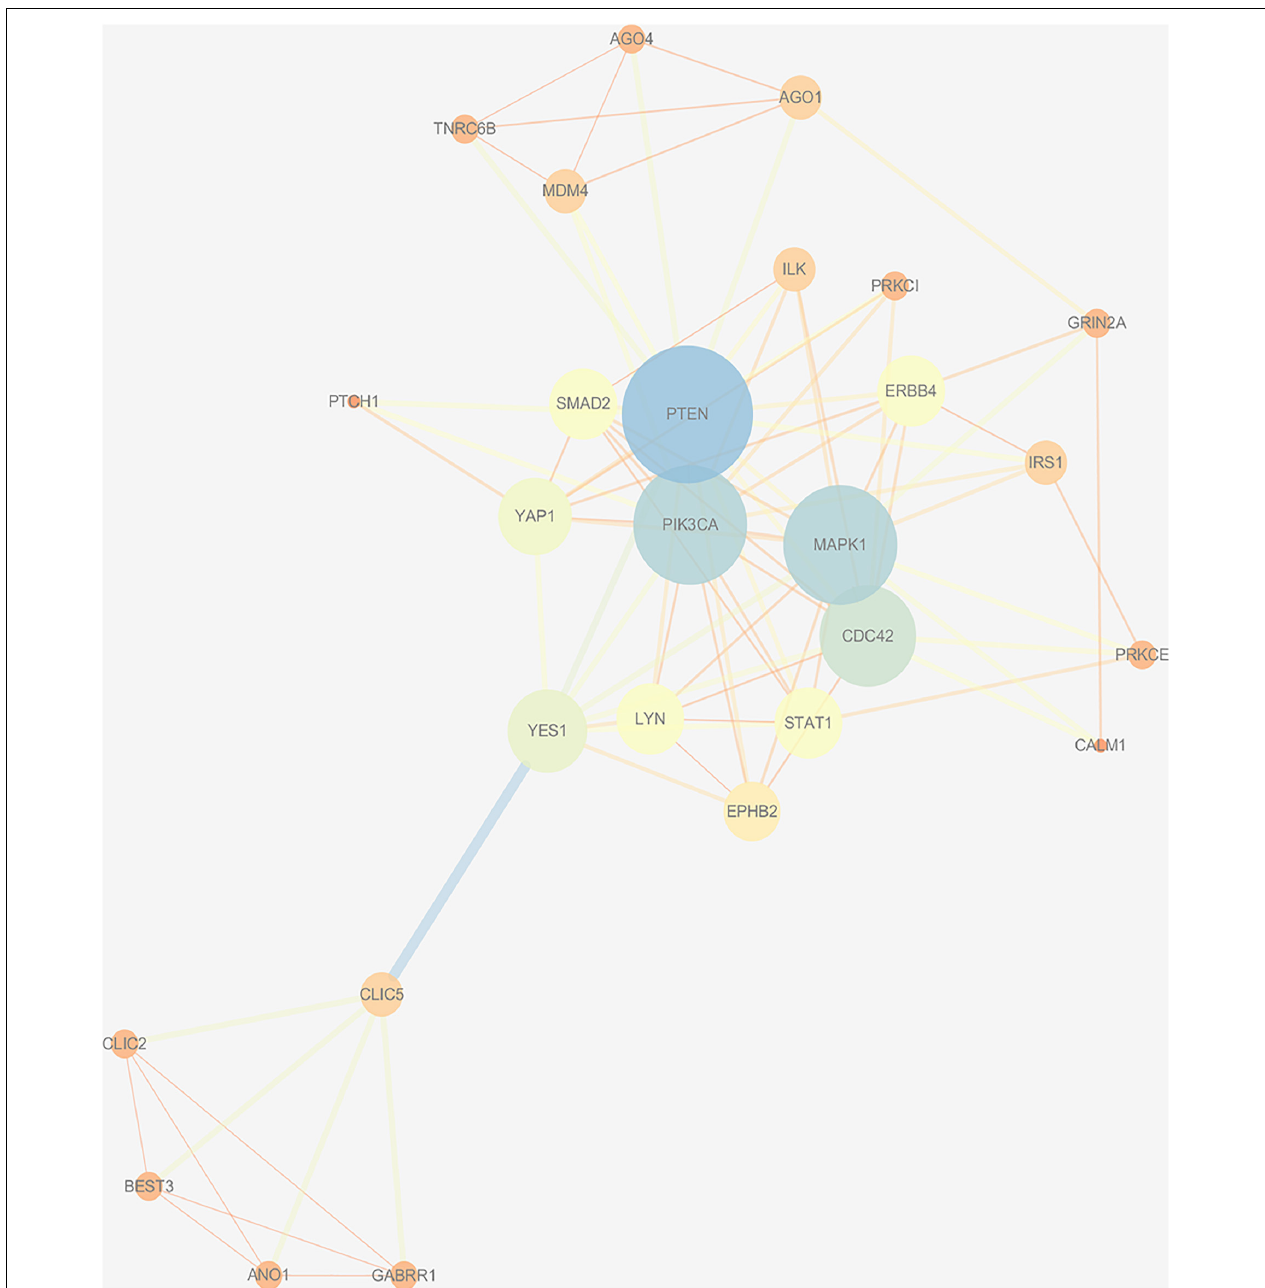
FIGURE 7 | Protein-protein interaction network was visualized by Cytoscape v.3.6.1. The selected cluster identified by MCODE. The size of node depends on significance of P -value. The more significant P -value, the larger the diameter of node is. The color of the edge represents the value of combined score from 0.4 to 1, light to